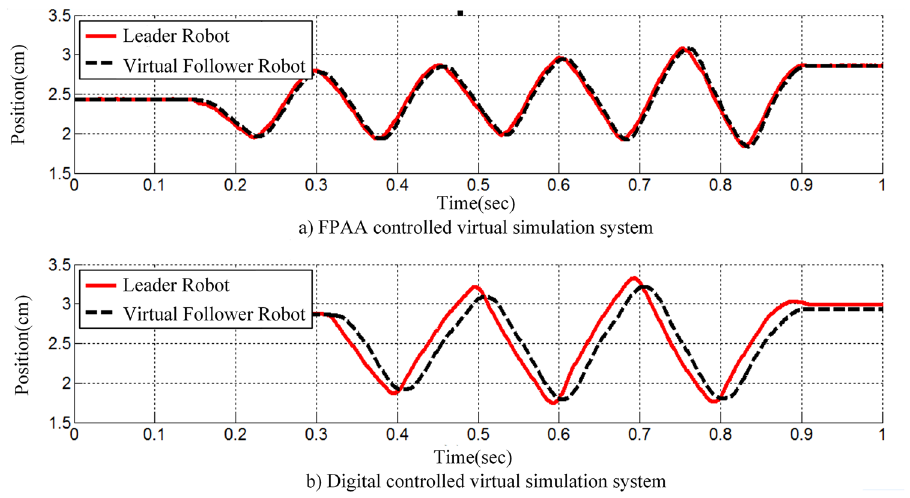
Figure 15. Leader–follower position tracking profiles under free motion for systems under digital and hybrid